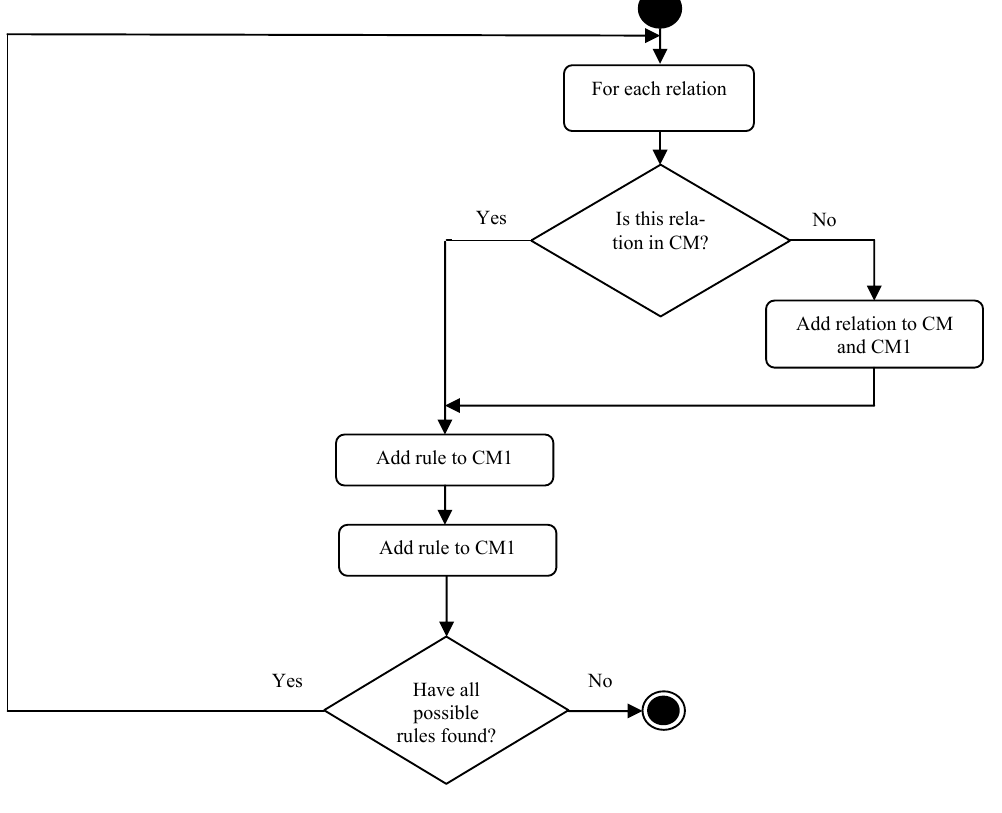
Fig.4. Ontology transformation step